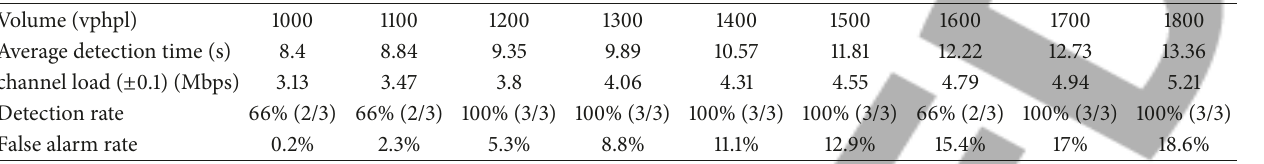
Table 6: Detection time, Channel load, Detection rate and False alarm rate of IASLD for different traffic volumes.